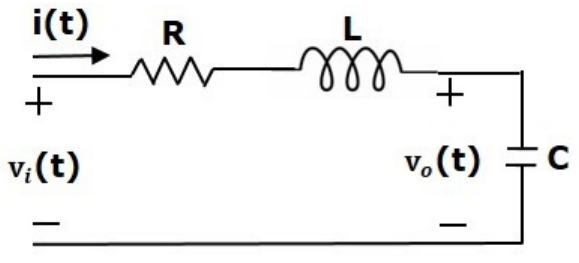
Figure 4. RLC circuit